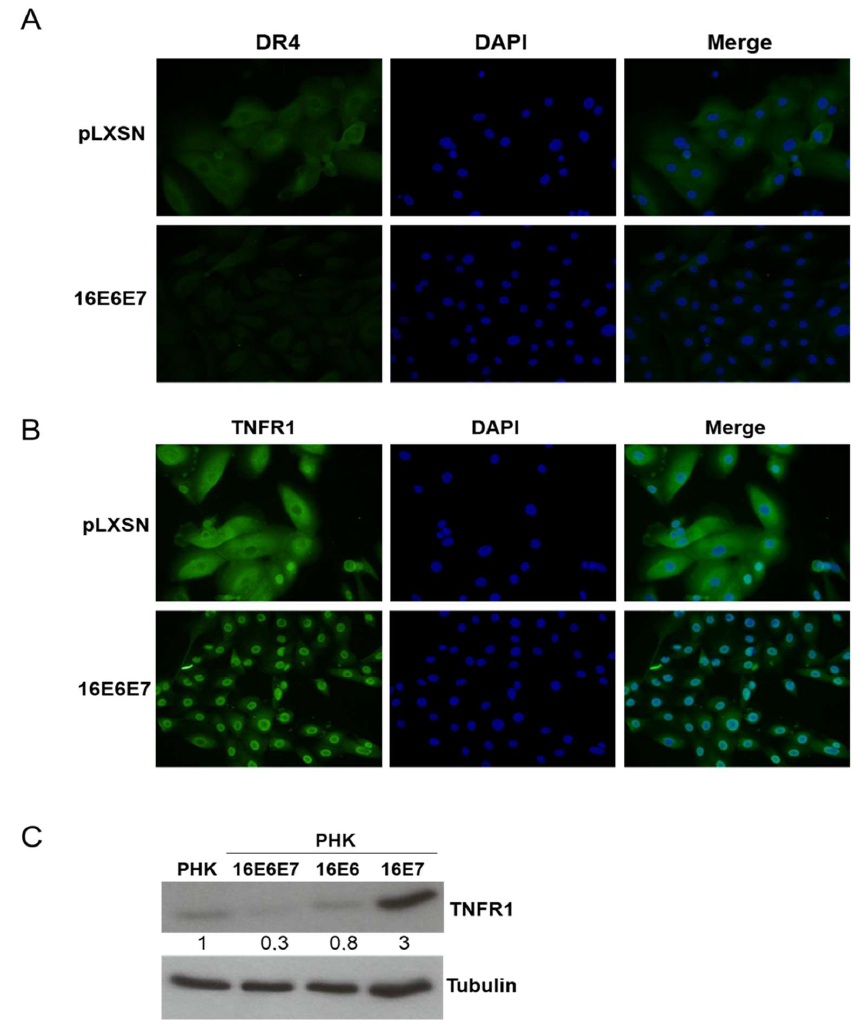
Figure 4. Expression of HPV16E6 and E7 is associated with TNFR1 down-regulation. The expression of DR4 and TNFR1 was determined by immunofluorescence in control (pLXSN) and HPV16 E6/E7 transduced PHKs. Control or HPV16 E6E7 expressing keratinocytes were seeded in 8 wells Lab-Tek chambers, fixed, permeabilized and incubated with anti-DR4 ( A ) or anti-TNFR1 ( B ). After washing, cells were incubated with FITC-conjugated anti-mouse and mounted with Vectashield mounting medium for fluorescence with DAPI. Images were obtained with an Olympus BX61, with attached DP70 Olympus camera and its own software (Olympus, Japan). Magnification: 200×. ( C ) TNFR1 levels were determined by western blot in total protein extracts obtained from the same cells. Relative proteins signals were quantified using ImageJ software.